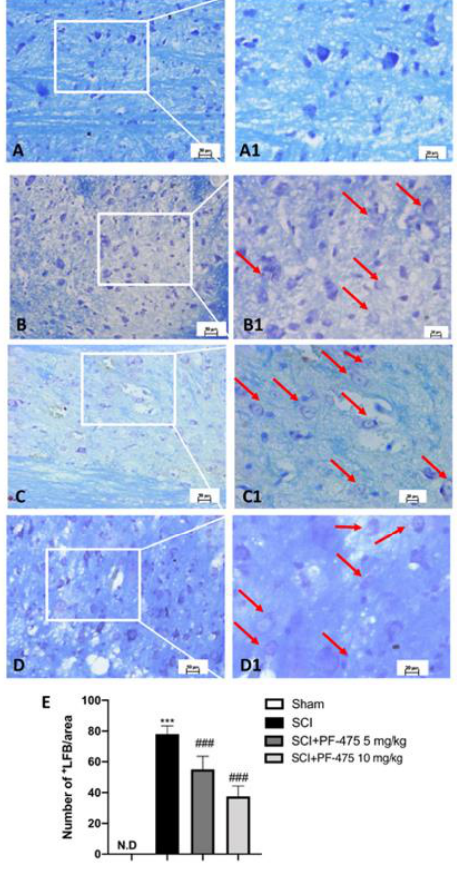
Figure 3. Effects of PF-475 on the myelination process evaluated in spinal cord sections. LFB staining showed healthy neurons (blue) in Sham group ( A , A1 ) and an accumulation of myelin (purple) in the SCI group ( B , B1 ). PF-475 treatments (2.5 and 5 mg/kg) after SCI groups reduced the myelin accumulation (( C , C1 , D , D1 ) respectively). Number of LFB+ cells over the total LFB area ( E ). Each data is expressed as SD from ten mice for each group. One-way ANOVA followed by Bonferroni post-test. (ND) Not detectable. *** p < 0.001 vs. Sham; ### p < 0.001 vs. SCI.